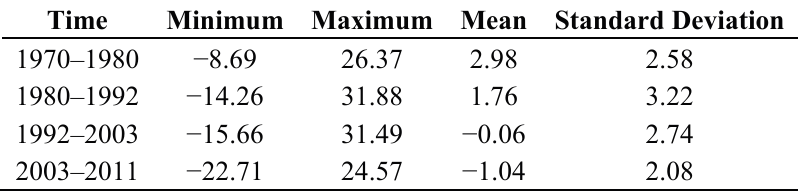
Table 5. Reclamation height in the Zhoushan Islands during different time